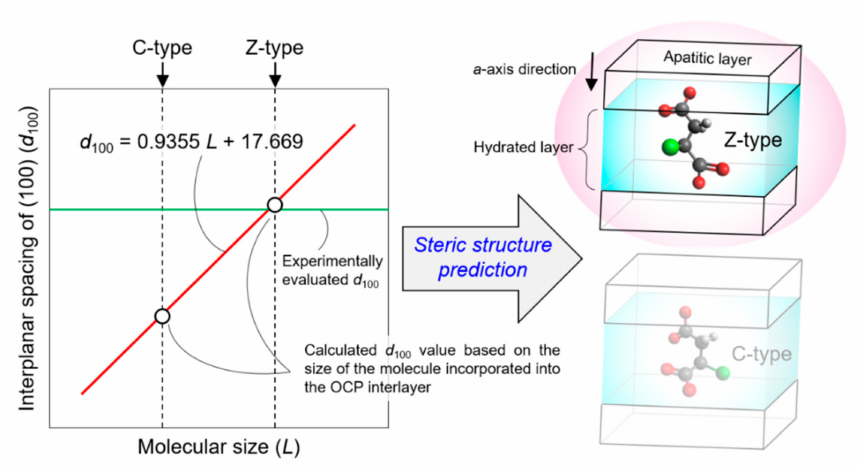
Figure 5. Computationally predicted steric structures of dicarboxylate ions incorporated into the OCP interlayer